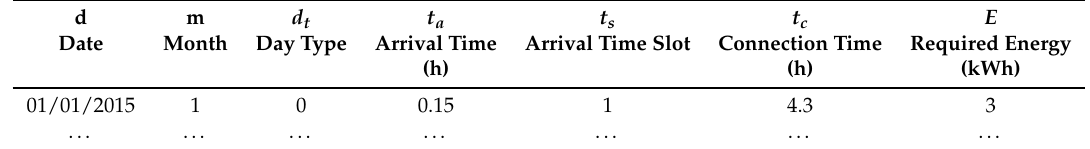
Table 1. Processed session data. Each row corresponds to an EV session.